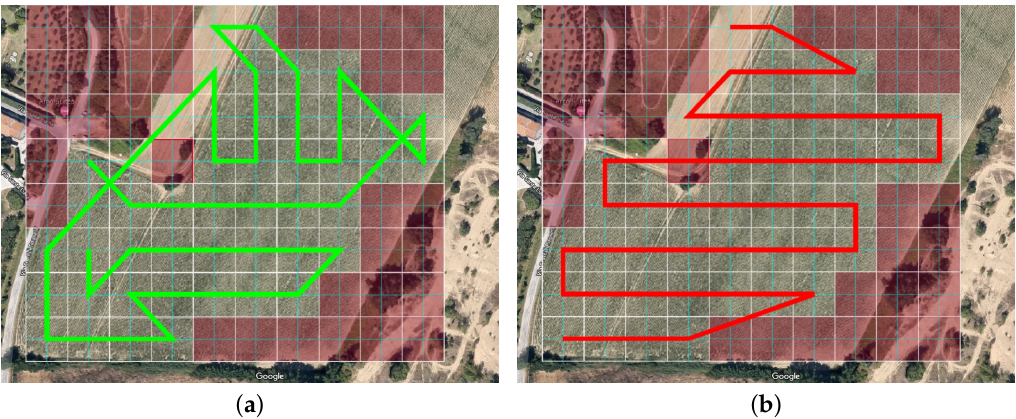
Figure 22. Trajectory Planning in our work versus the work in [31]. ( a ) trajectory planning by Di Franco et al. [31]; ( b ) trajectory plan by our work.